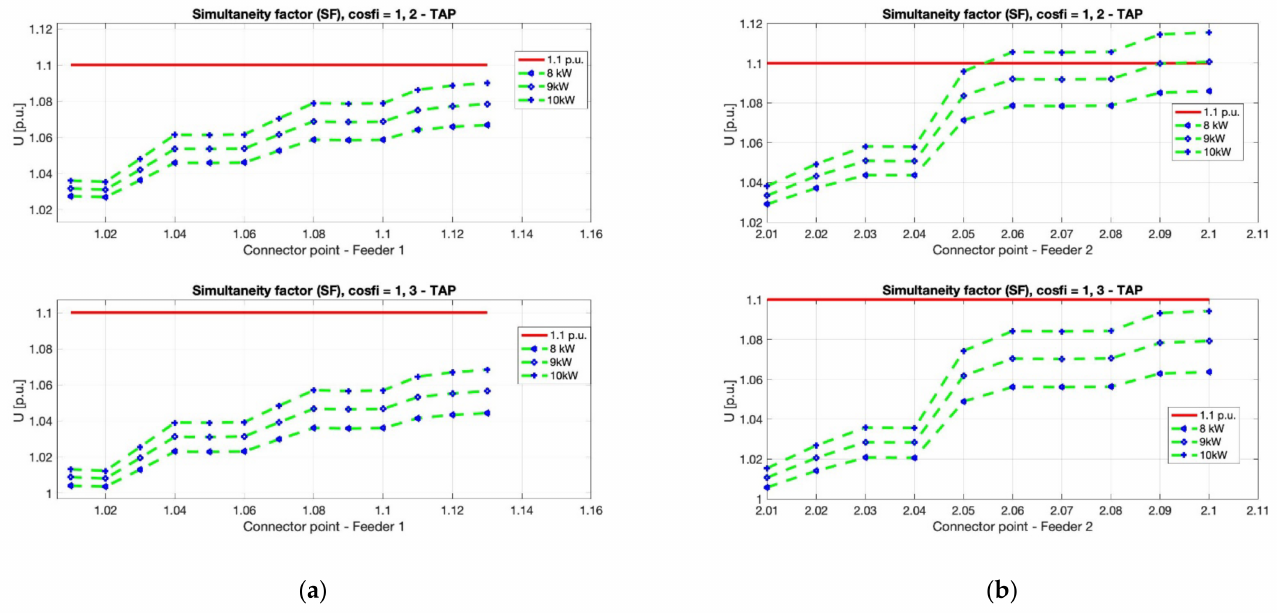
Figure 4. Scenario SF, power factor = 1, TAP-2 and 3, Feeder 1—( a ) and Feeder 2—( b